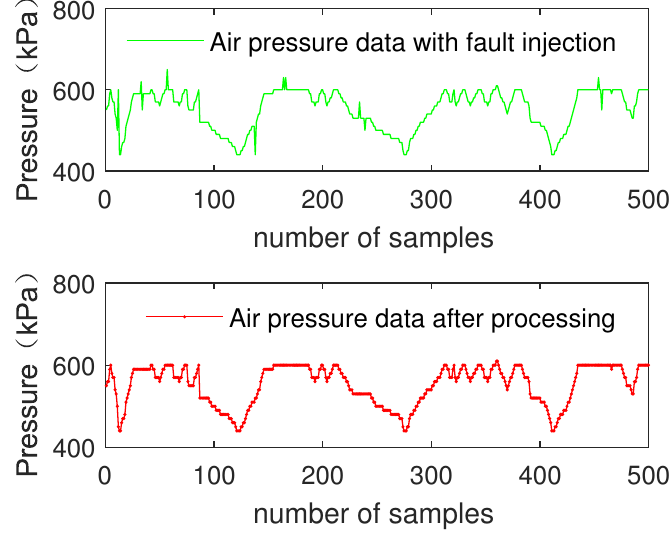
Figure 10. Single input of air pressure data with fault injection and processed